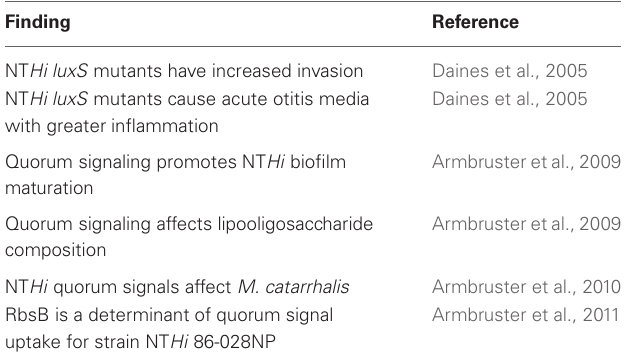
Table 1 | Current knowledge about quorum signaling/sensing in H. influenzae .